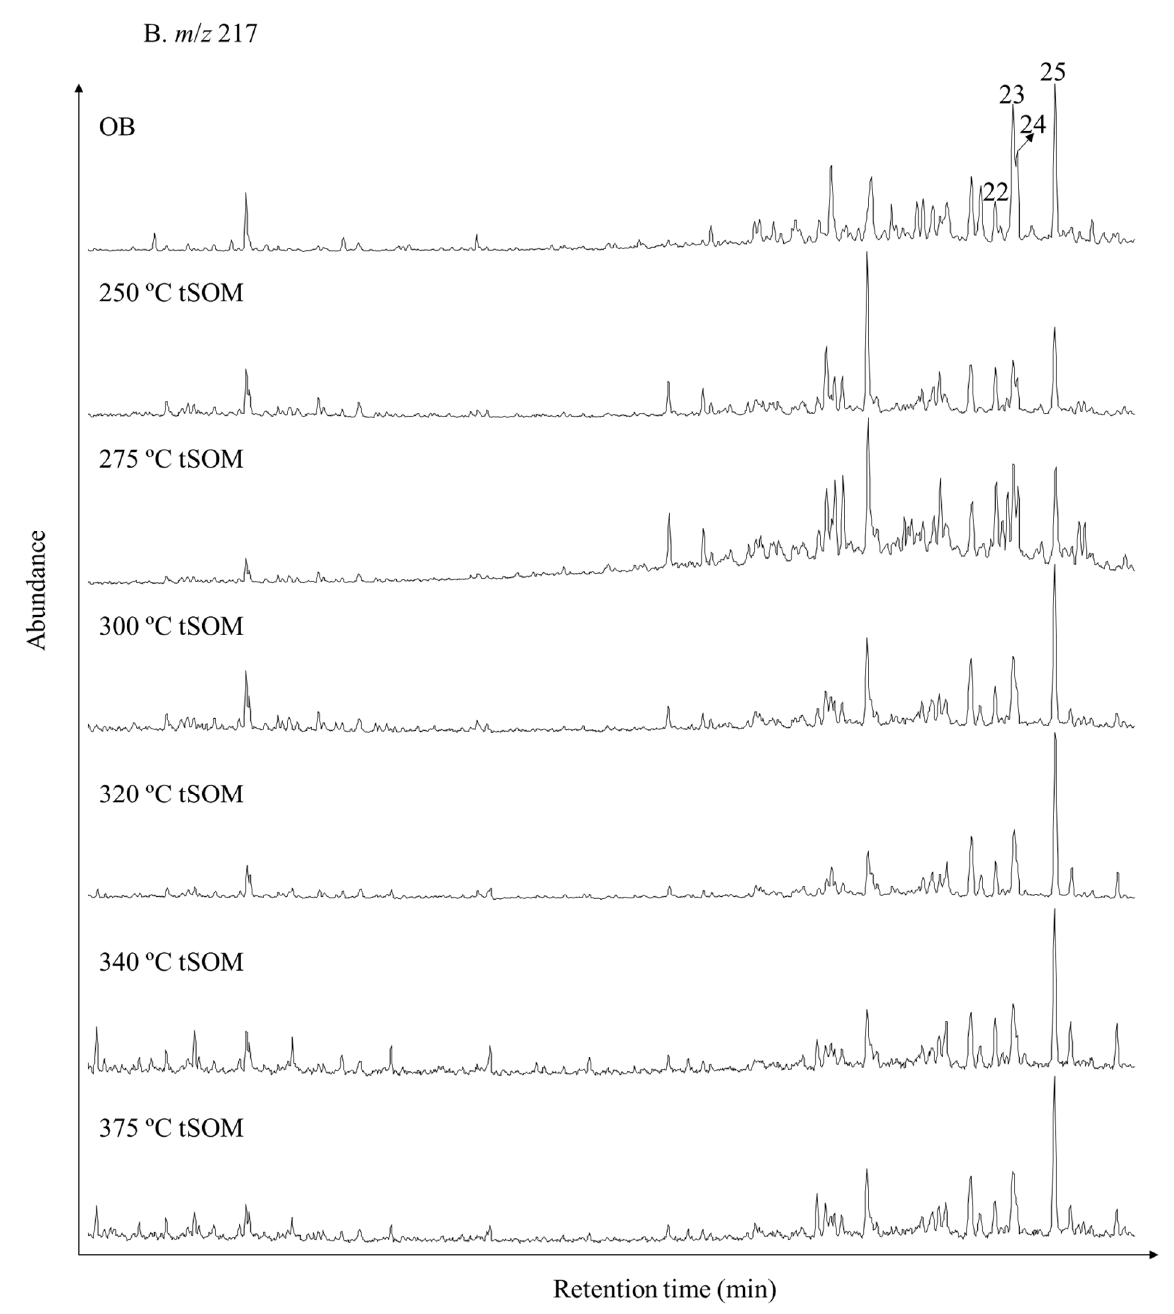
Figure 4. Distribution pattern of ( A ) terpanes on the m / z 191 selected ion chromatogram trace and ( B ) steranes on the m / z 217 trace in the OB and the tSOMs (own elaboration). Peak identification was referred to Farrimond et al., (1996): 1. C 21 tricyclic terpane; 2. C 23 tricyclic terpane; 3. C 27 18 α -22,29,30-trisnorneohopane (Ts), 4. C 27 17 α -22,29,30-trisnorhopane (Tm); 5. C 27 17 β -22,29,30-trisnorhopane; 6. C 29 neohop13(18)ene; 7. C 29 αβ -norhopane; 8. C 29 18 α -30-norneohopane (C 29 Ts); 9. C 29 βα -moretane; 10. C 30 αβ -hopane; 11. C 30 neohop13(18)ene; 12. C 29 ββ -hopane; 13. C 30 βα -moretane; 14. C 31 αβ -22 S -hopane; 15. C 31 αβ -22 R -hopane; 16. C 30 ββ -hopane; 17. C 32 αβ -22 S -hopane; 18. C 32 αβ -22 R -hopane; 19. C 31 ββ -hopane; 20. C 33 αβ -22 S -hopane; 21. C 33 αβ -22 R -hopane; 22. C 29 αα S -sterane; 23. C 29 ββ R -sterane; 24. C 29 ββ S -sterane; 25. C 29 αα R -sterane. Table 1. Changes in investigated isomer concentrations ( μ g/g tSOM), compound class concentra- tions ( μ g/g tSOM) and biomarker ratios in the OB and the tSOMs (own elaboration).